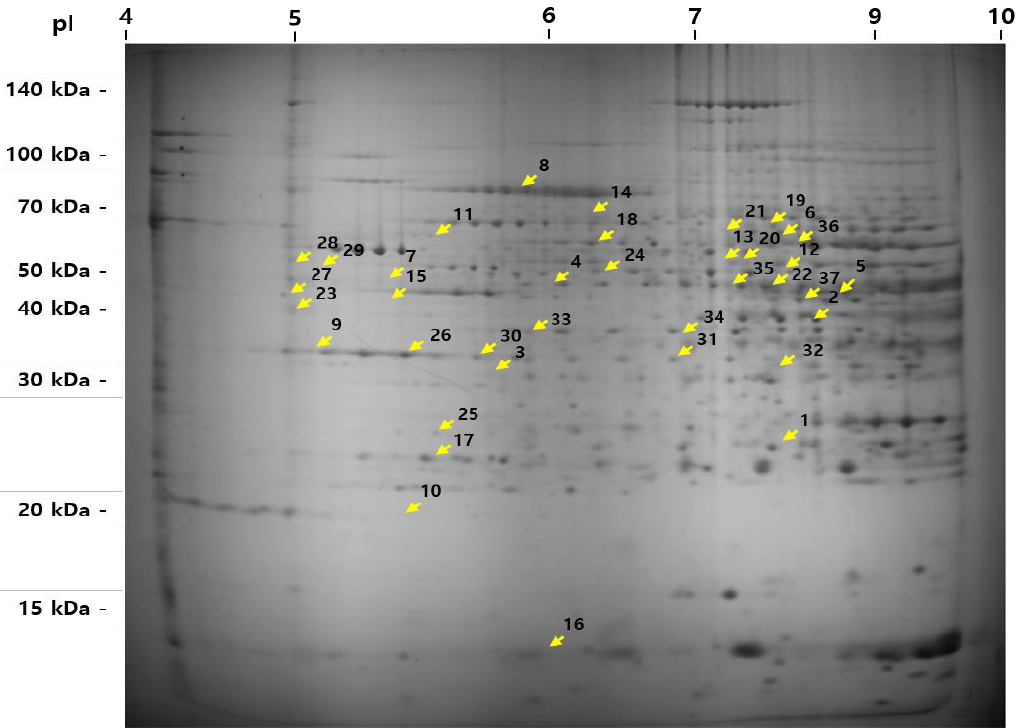
Figure 4. Two-dimensional electrophoresis of proteins in the liver. The 2-D PAGE image from the liver was used as a master gel and reference map. The HFD caused 37 spots to change. The protein spots were identified by MALDI-TOF (arrow) and are marked by their spot numbers. pI, isoelectric point.